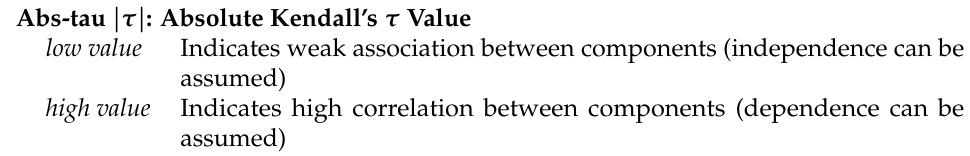
Table 7. Parameter metrics for explaining the intuition behind